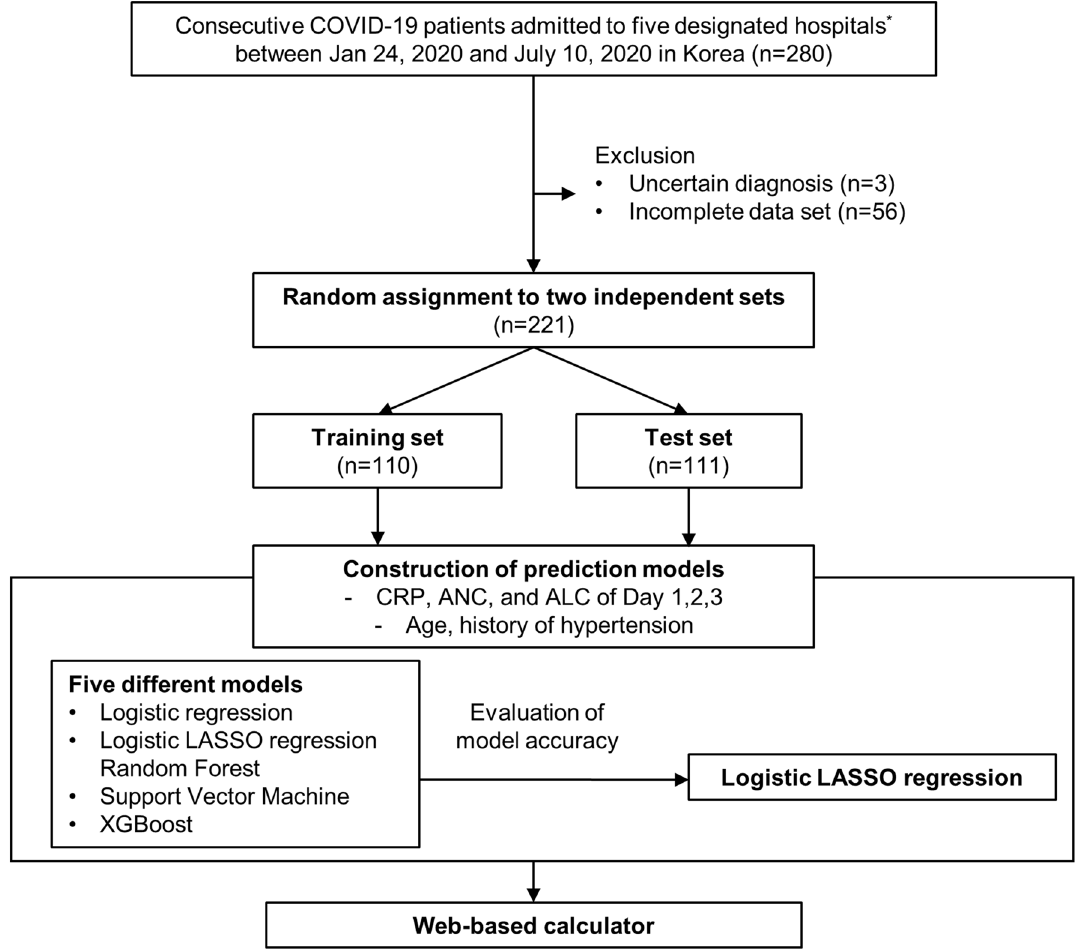
Figure 1. Study design and patient flow. * National Medical Center (n = 128), Seoul National University Hospital (n = 46), Armed Forces Capital Hospital (n = 41), Myongji Hospital (n = 40), and Seoul National University Bundang Hospital (n = 25). ALC, absolute lymphocyte count; ANC, absolute neutrophil count; CRP, C-reactive